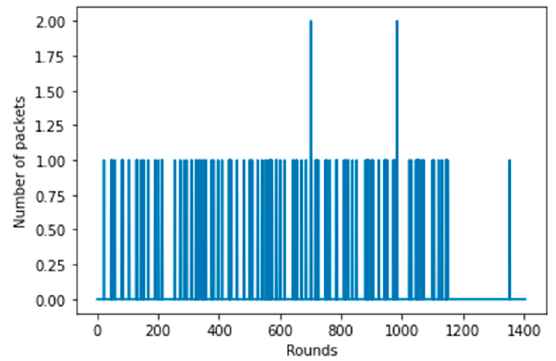
Figure 12. Retransmissions per round in FEHCA.